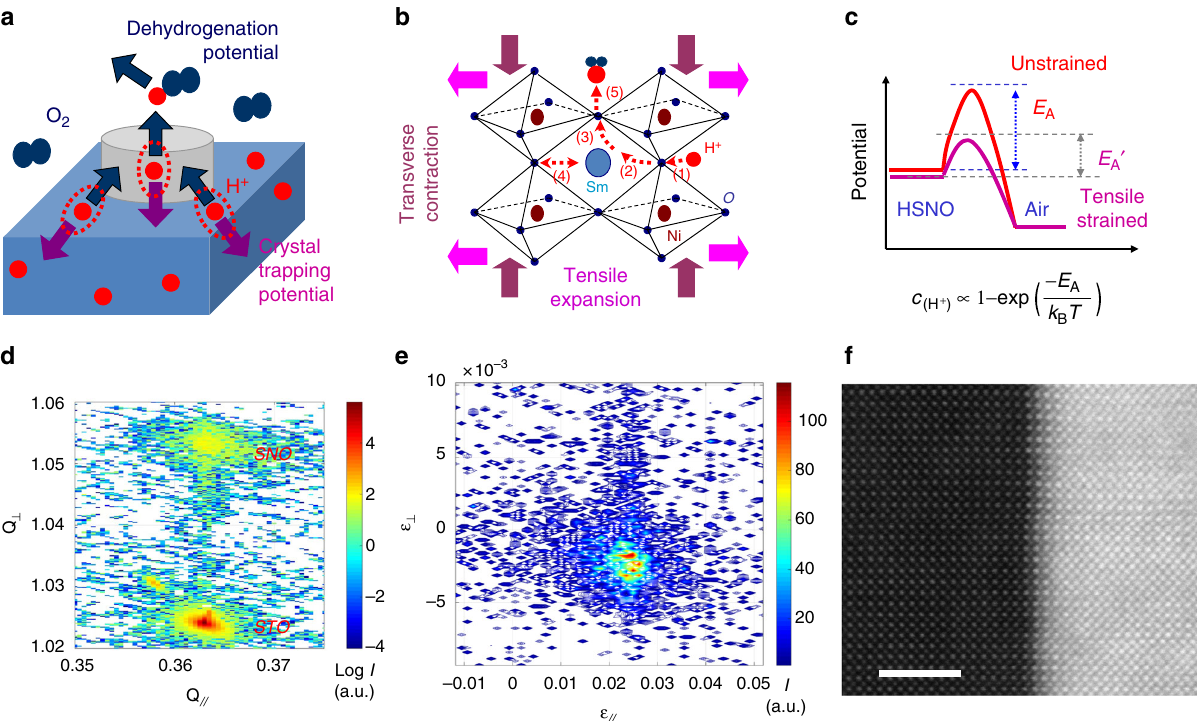
Fig. 2 Tensile distortion of SmNiO 3 . a Illustration of the two competing processes taking place within the lattice of SmNiO 3 : (1) Hydrogen diffusing out of the material driven by the dehydrogenation potential when exposed in an oxygen containing atmosphere, (2) being trapped within SmNiO 3 due to the energy barrier provided by the lattice. b Illustrating the proton transport processes within SmNiO 3 : (1) proton incorporation, (2) rotational diffusion and (3) transport of protons, (4) bending and stretching of the Ni-O bond in the opposite side. Imposing tensile distortion upon SmNiO 3 improves step (2) and (3) owing to the elongated Ni-O, and thereby enhances the proton diffusion coef fi cient. c Fast diffusion of hydrogen is expected owing to the reduced energy barrier ( E A ) after tensile distortion of SmNiO 3 . d Reciprocal space mapping (RSM) of SmNiO 3 /SrTiO 3 (001) and e the strain distribution of the fi lm material converted from RSM. f Cs-corrected STEM high-angle annular dark- fi eld (HAADF) image of the interface for the SmNiO 3 /SrTiO 3 (001). Scale bar is 3